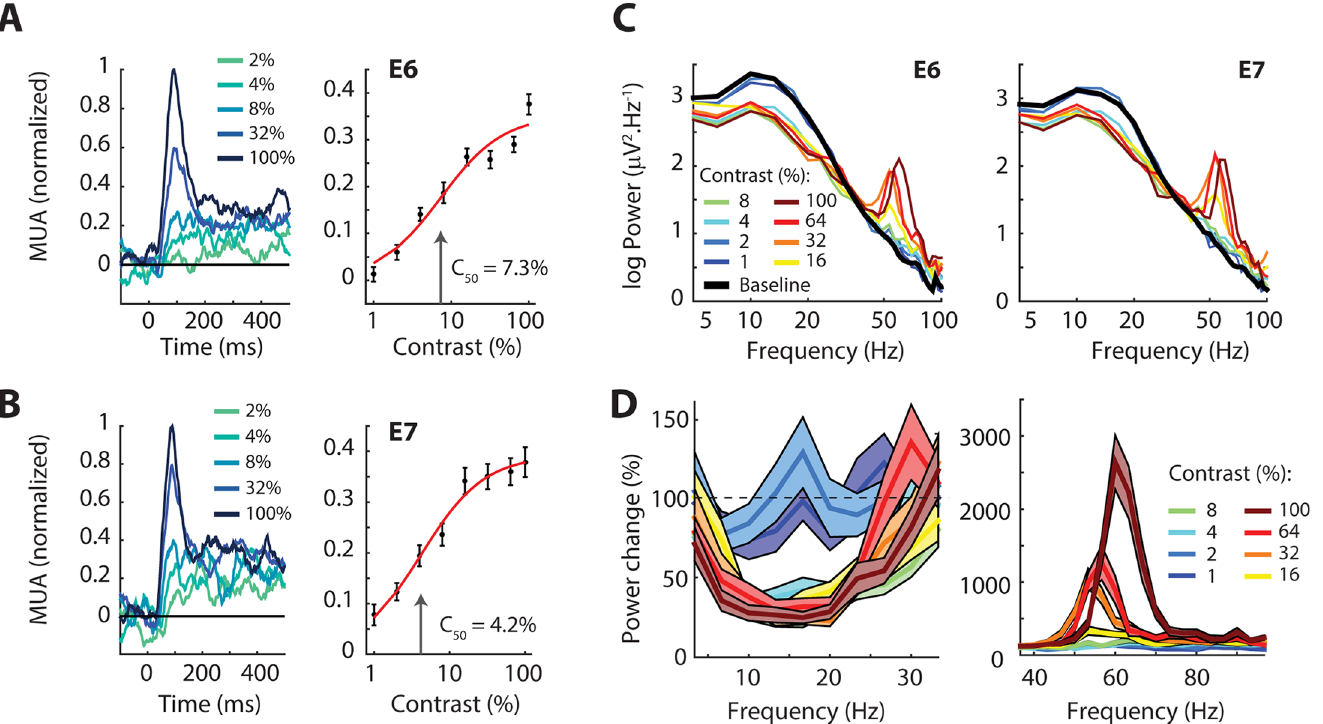
Fig 4. Contrast tuning of MUA and LFP. (A) Left panel, The MUA response evoked by drifting gratings of various contrasts at electrode E6. Gratings with a higher contrast evoked stronger MUA responses with a shorter latency. Right panel, the average MUA response in a window from 0 – 500 ms. The error-bars show +/- 1 S.E.M. The red line is the fit of the Naka-Rushton equation. The semi-saturation point (C 50 ) is shown by the arrow. (B) Data from E7, the same format as in A. (C) Power spectra of the LFP of E6 and E7 elicited by gratings of different contrasts and the pre-stimulus baseline (black line). Contrasts above 2% suppress lower frequencies, and the highest contrasts induce a clear gamma peak. (D) The relative change in power for low frequencies (left panel) and high frequencies (right panel) compared to the pre-stimulus baseline, averaged across E6 and E7. Note the different scale on the y -axis in the two panels. The shaded regions are +/- 1 S.E.M. Data is available from